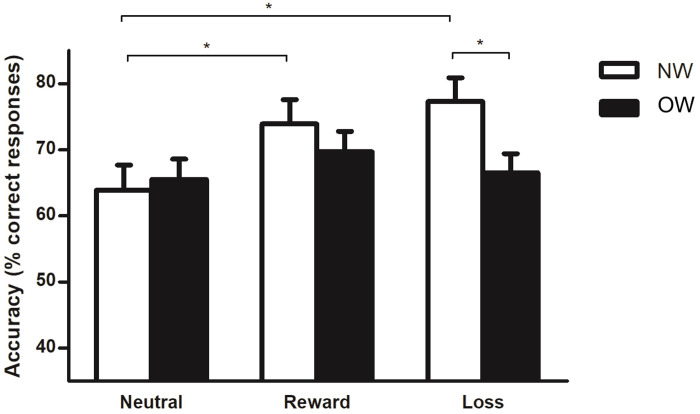
Incentivized antisaccade task accuracy between Normal-Weight (NW) and OverWeight (OW) groups.Values are expressed as mean ± standard error. Statistical analysis was performed with repeated measures analysis of variance; * p < 0.05 ** p < 0.005.